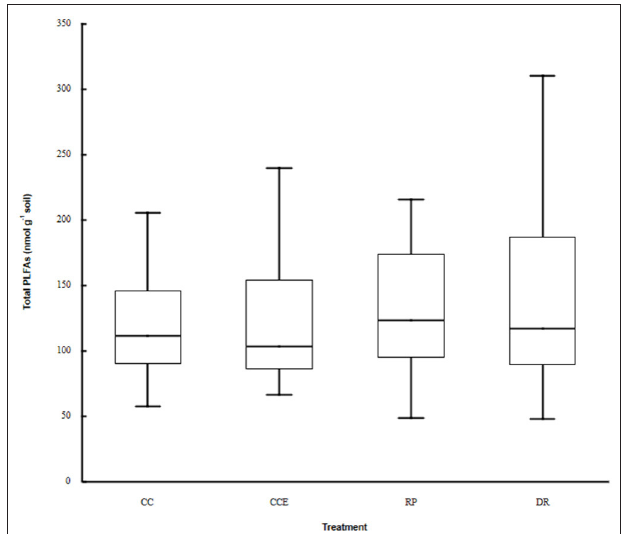
FIGURE 1 | Total microbial biomass in the dispersed retention (DR) treatment, the retention patch (RP), in the clear-cut treatment (CC, 9m, or more from the retention patch) and in the clear-cut edge treatment (CCE, within 9m of the retention patch).